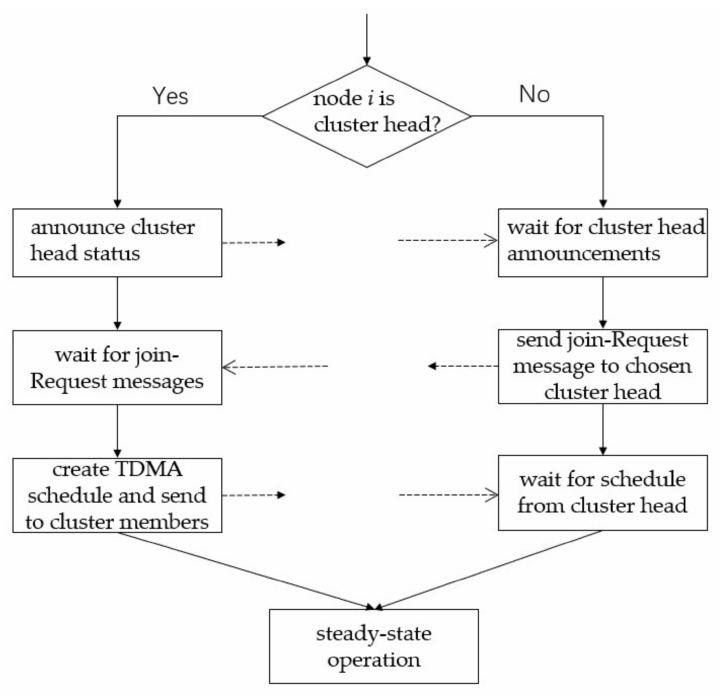
Figure 1. The step of low energy adaptive clustering hierarchy